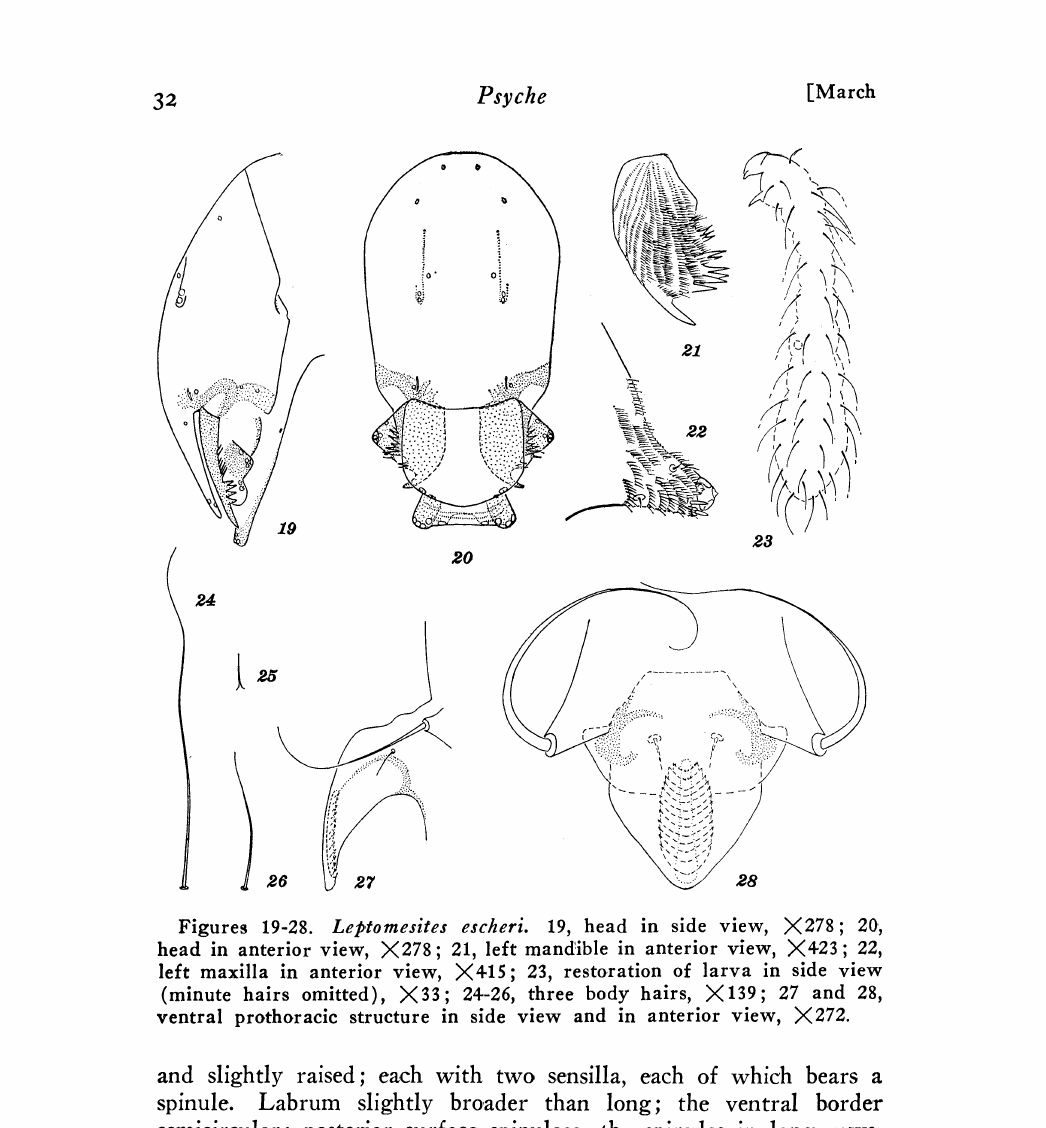
Figures 19-28. Leptomesites escheri. 19, head in side view, X278; 20, head in anterior view, X278; 21, left mandible in anterior view, X423; 22, left maxilla in anterior view, X415; 23, restoration of larva in side view (minute hairs omitted), X33; 24-26, three body hairs, X139; 27 and